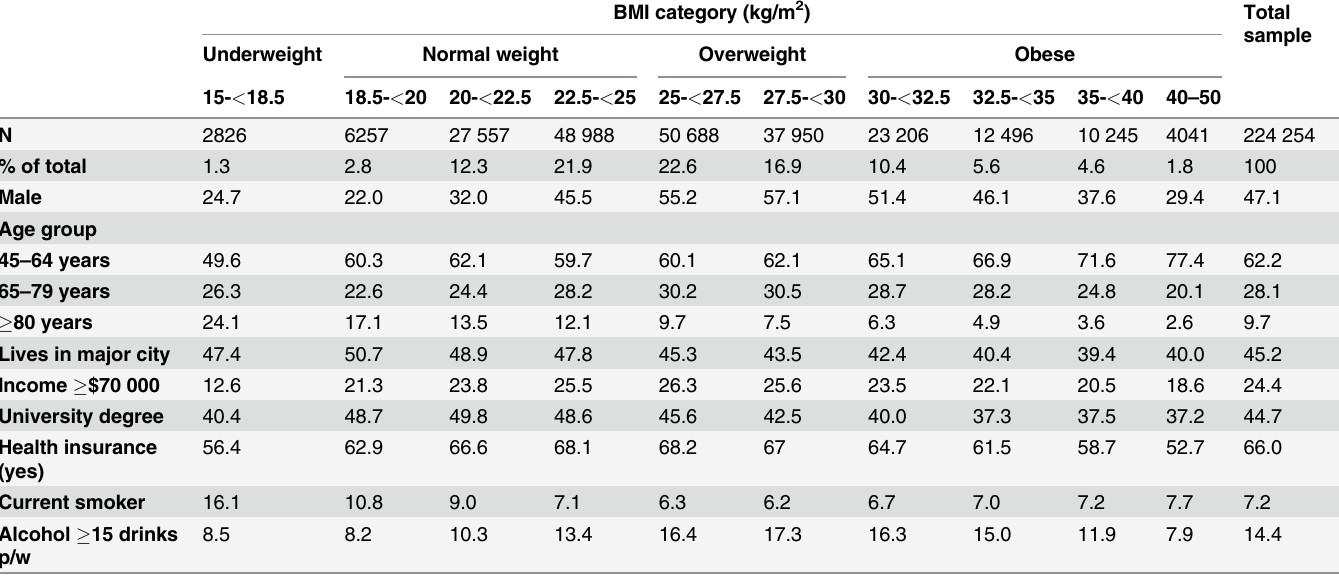
Table 1. Demographic and health characteristics of the